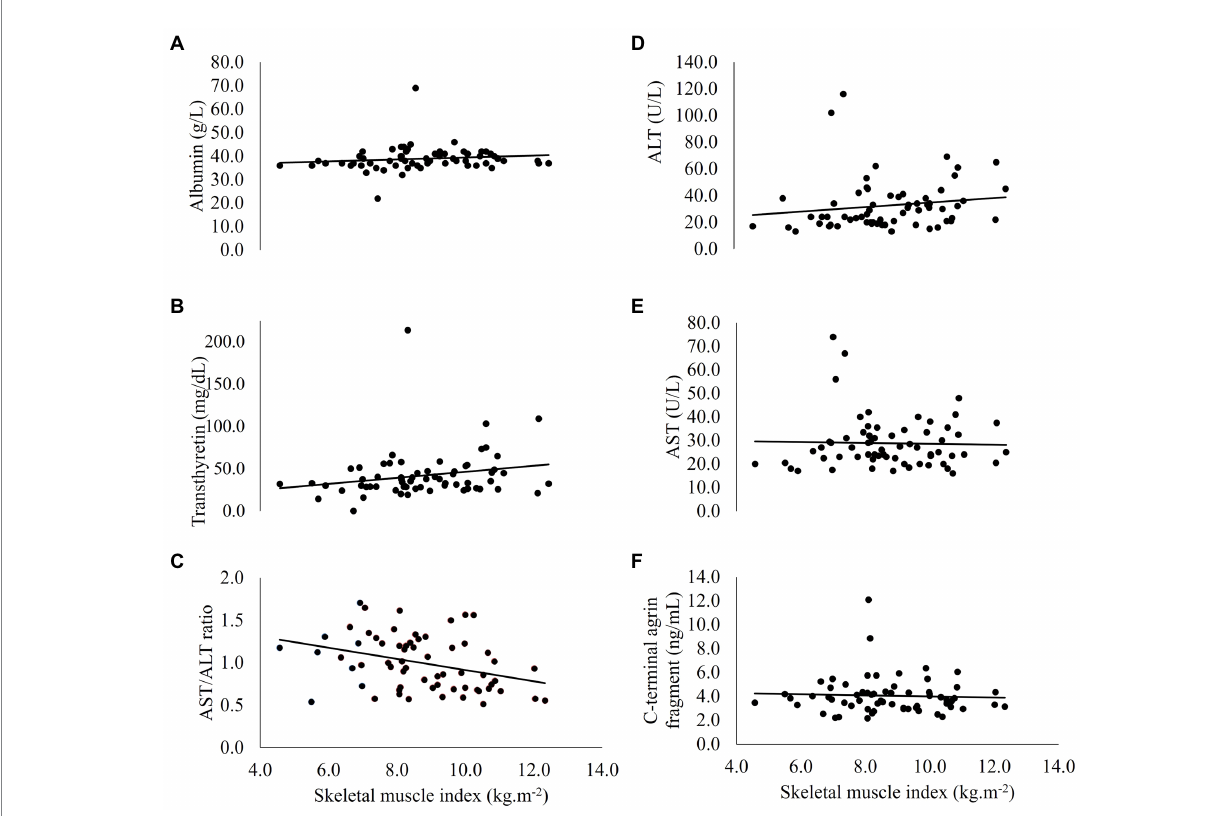
FIGURE 1 Correlations between skeletal muscle index and circulatory (A) albumin, (B) transthyretin, (C) AST/ALT ratio, (D) ALT, (E) AST, and (F) C-terminal agrin fragment, in people with coronary heart disease ( n = 64). ALT, alanine aminotransferase; AST, aspartate